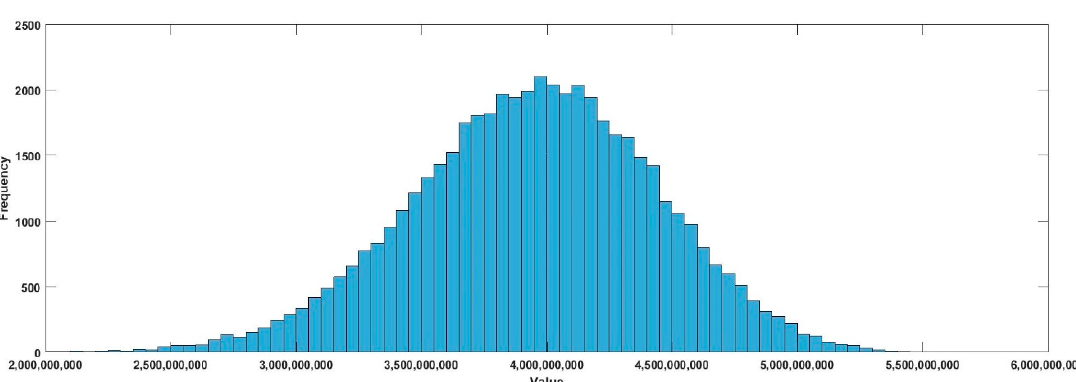
Figure 6. Histogram of the objective function for the greensociety/high value model.